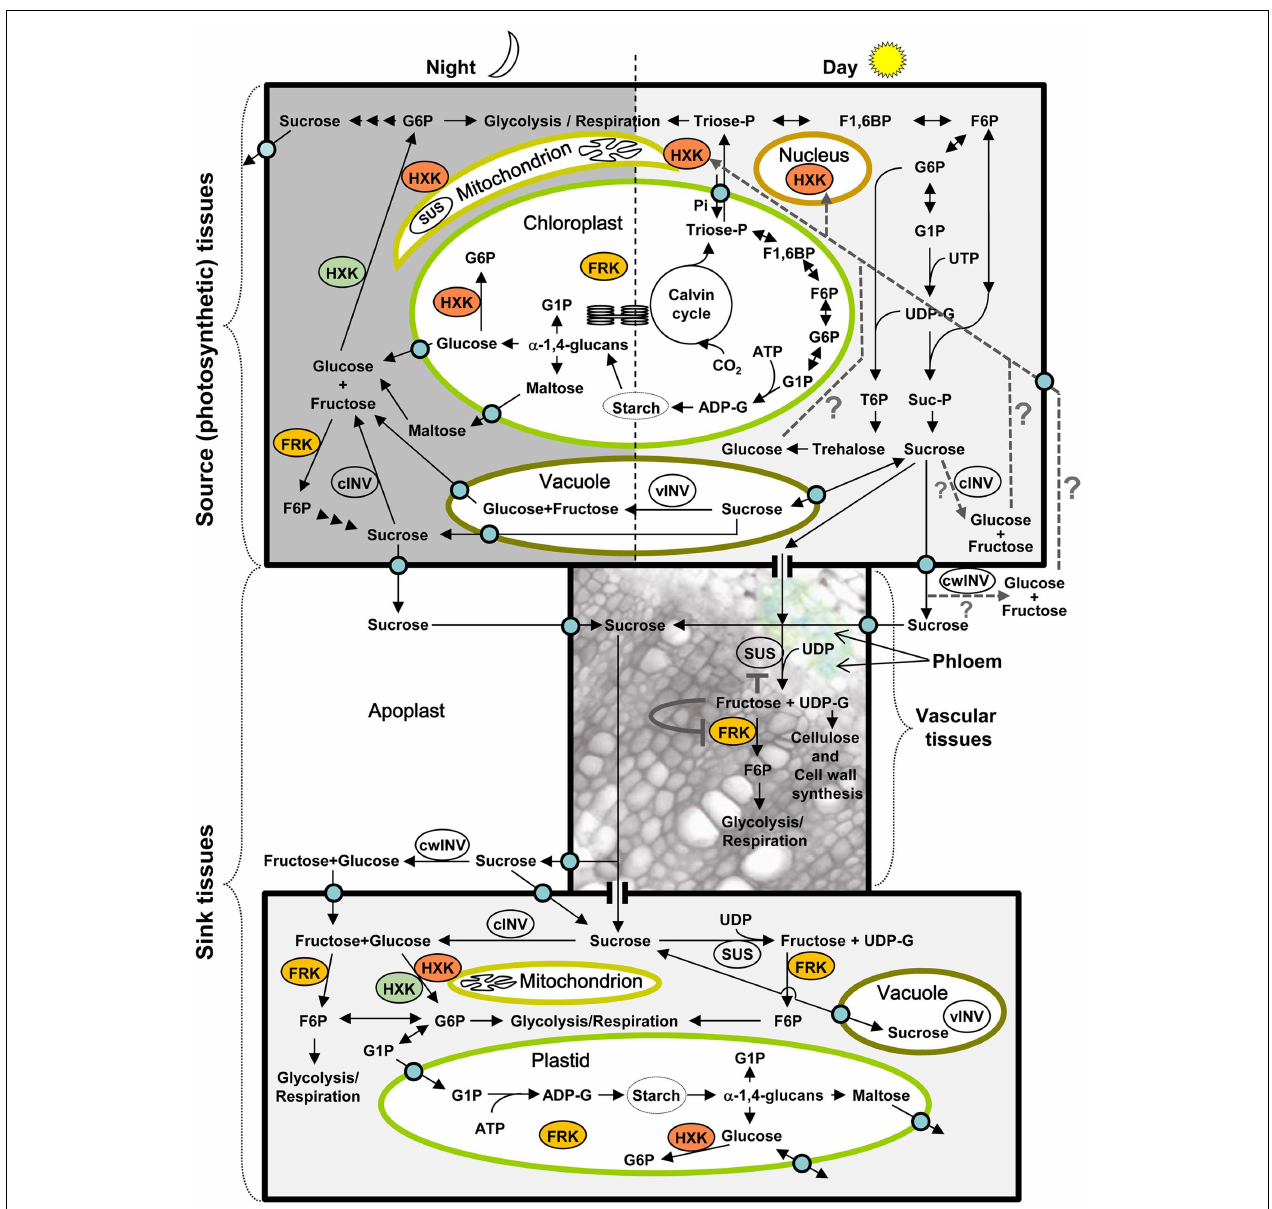
monocots. Sucrose transported to the apoplast, during the day or night enters the phloem via sucrose transporters.Within the vascular tissues, sucrose can be cleaved by sucrose synthase (SUS) to support vascular development or transported to other sink tissues. Sucrose unloading in sink tissues may proceed symplasmically via plasmodesmata or through the apoplast via sucrose transporters. Alternatively, sucrose might be cleaved by apoplastic (cell wall) invertase (cwINV) to produce glucose and fructose that would enter sink cells via specific hexose transporters.The enzymatic steps of sugar metabolism in sink tissues are similar to those found in source tissues. In addition to the metabolic function of HXK, this enzyme also senses the presence of glucose and represses the expression of photosynthetic genes in the nucleus of source photosynthetic tissues.The origin of the glucose in photosynthetic tissues that is sensed by HXK is not known. Potential sources are presented by dashed lines: cleavage of sucrose or trehalose within the cytosol, or apoplastic cleavage of sucrose followed by uptake of the released